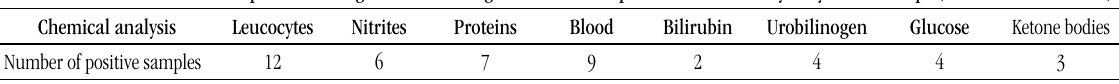
tABLE 1 – Absolute number of positive findings from non-refrigerated urine samples in chemical analysis by reactive strips (collection = time zero) Chemical analysis